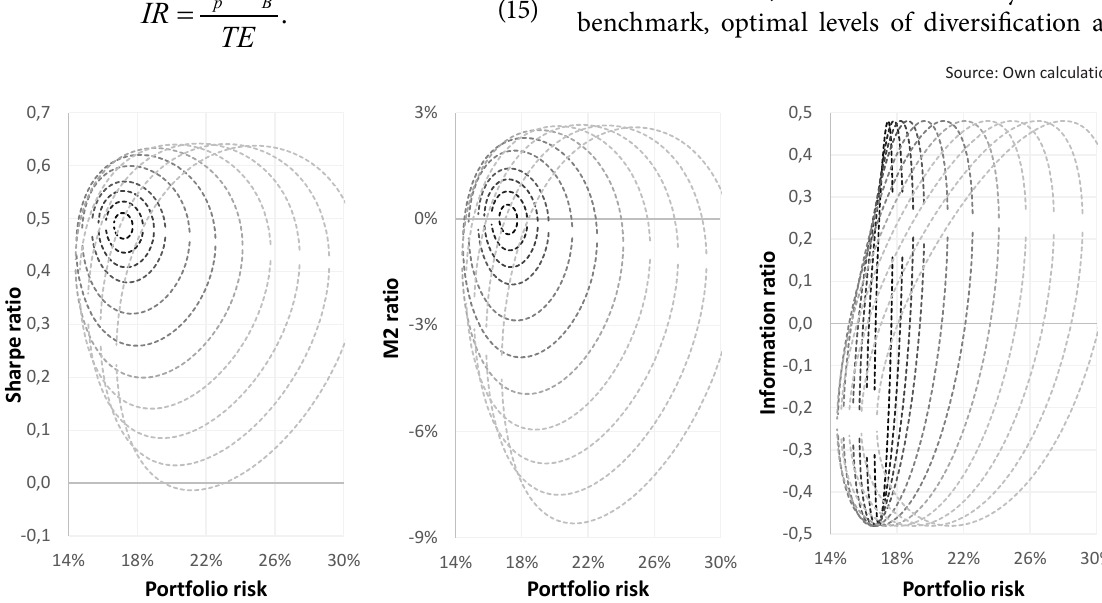
Figure 8. The loci of possible (a) Sharpe ratios, (b) M 2 ratios and (c) IRs – as a function of portfolio risk – for increasing TE